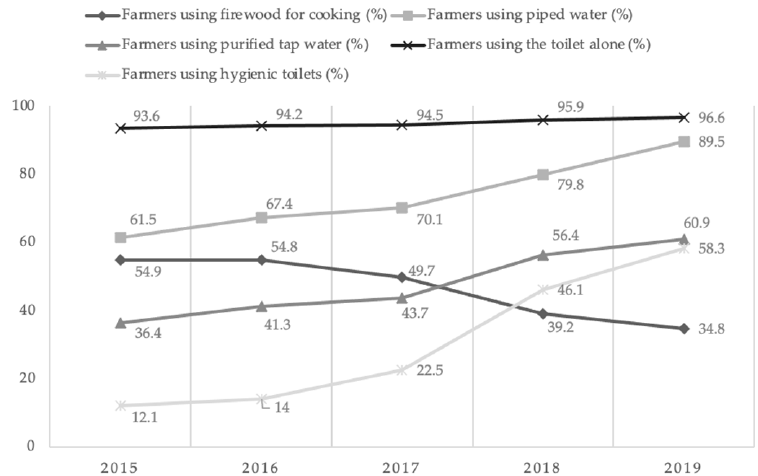
Figure 2. Habitat Improvement Trends in Poverty-stricken Areas in China, 2015–2019. Source: China Rural Poverty Monitoring Report.